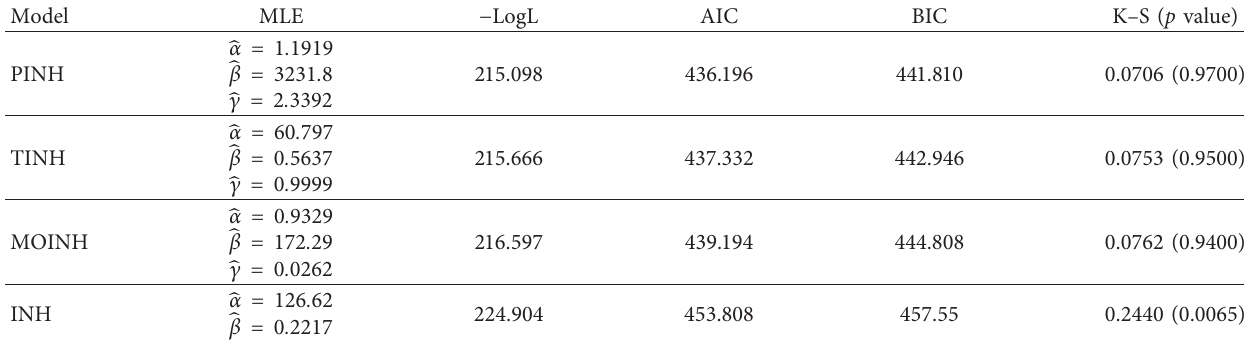
Table 4: ML estimates and goodness-of-fit measures for the first data set.